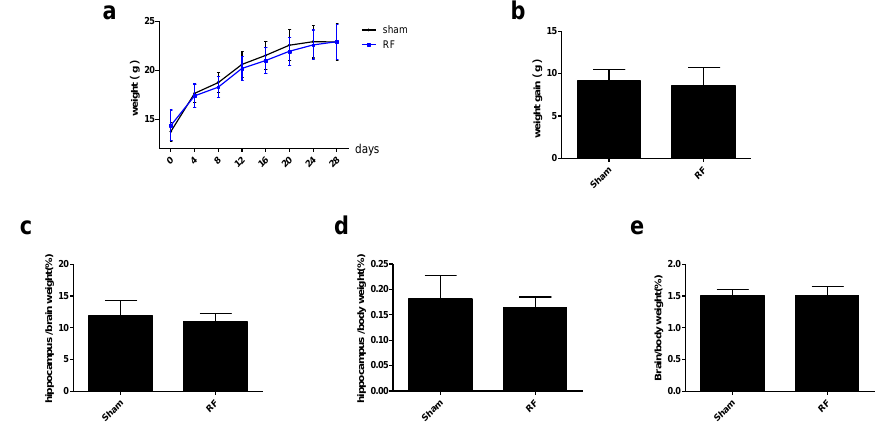
Figure 6. Effects of RF exposure on body and organ weight. ( a ) growth curve (within group: df = 7, F = 657.019, P < 0.001; between groups: df = 1, F = 0.251, P = 0.619), ( b ) weight gain (t = 1.3, df = 68, P = 0.198), ( c ) the ratio of the hippocampus weight to the brain weight (t = 1.615, df = 48, P = 0.113), ( d ) the ratio of the hippocampus weight to the body weight (t = 1.751, df = 48, P = 0.086), ( e ) the ratio of the brain weight to the body weight (t = 0.145, df = 48, P = 0.886). The data are presented as mean ± SD. No significant difference was observed between the sham and RF groups ( P > 0.05).